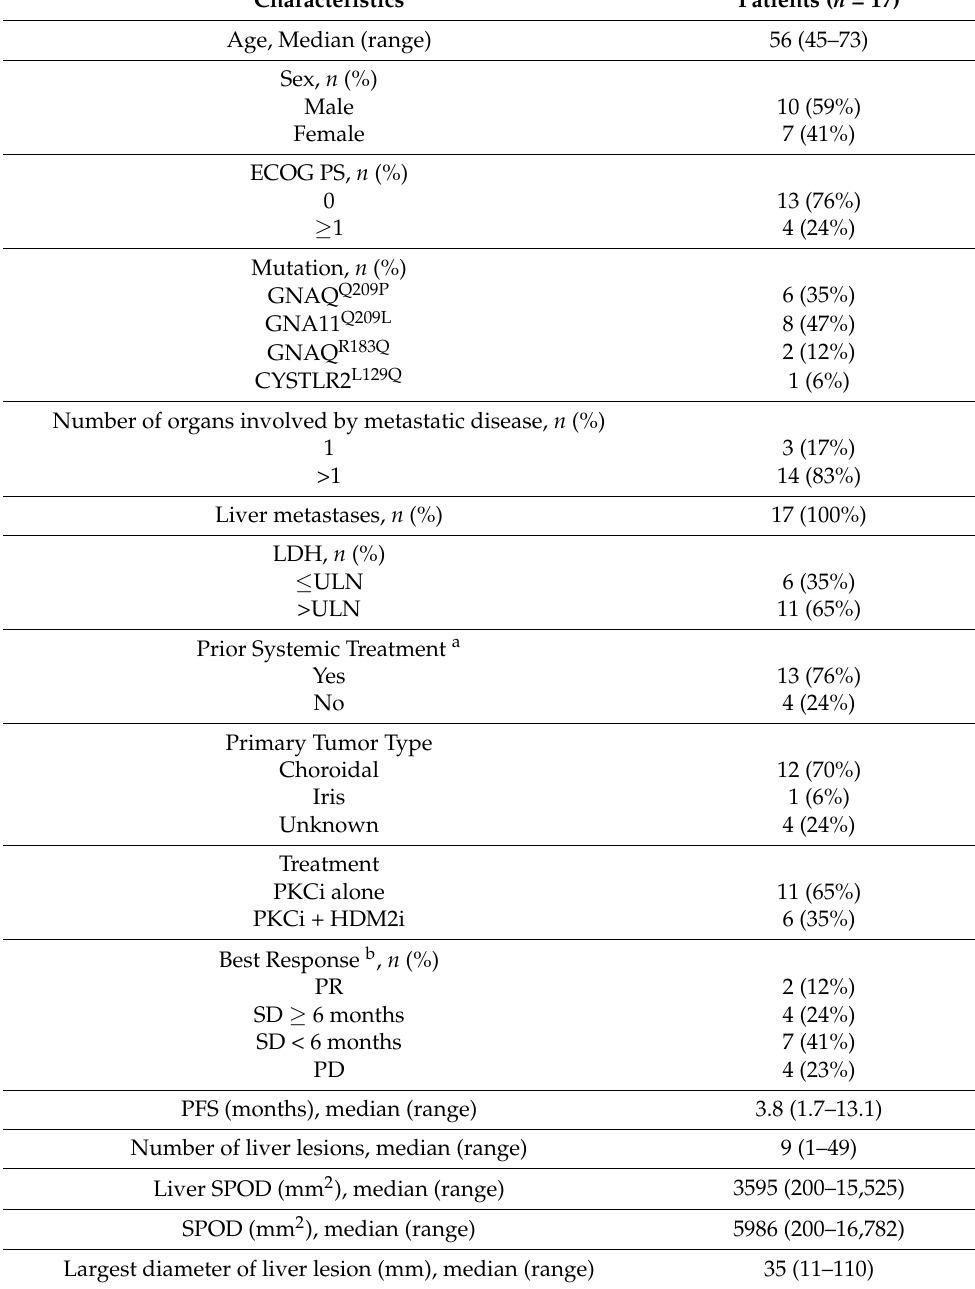
Table 1. Baseline clinicopathologic characteristics of uveal melanoma